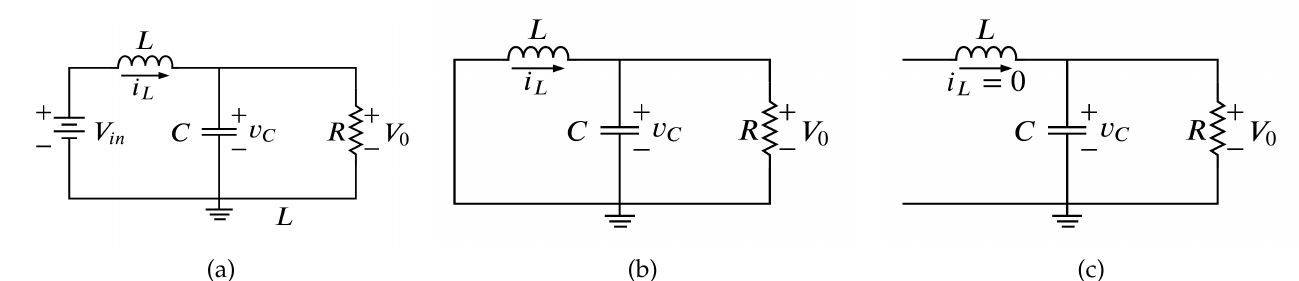
Figure 2. Topology of the equivalent circuits for a: ( a ) continuous conduction mode, ( b ) continuous conduction mode with the diode in forward bias, and ( c ) discontinuous conduction mode with the diode in reverse